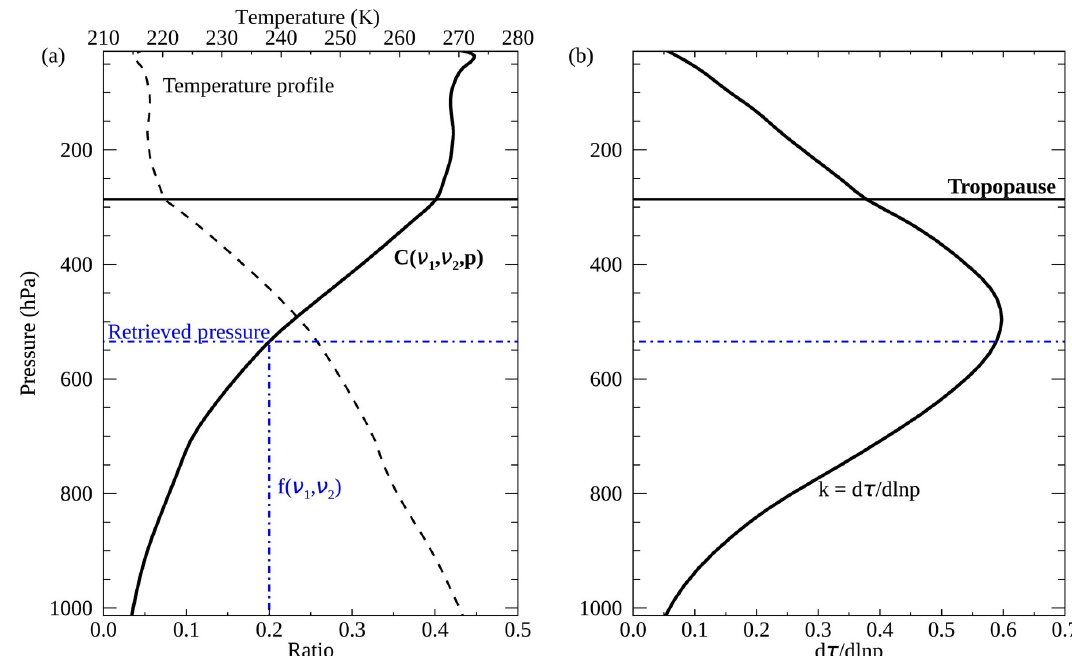
Figure 2. (a) An example of the cloud pressure function calculated using Eq. (2). This is strongly linked to the atmospheric temperature profile (dashed black line). The value obtained with Eq. (1) is compared against the cloud pressure function, and where these intersect is taken as the cloud pressure solution for that channel. In this example ν 1 and ν 2 are at 715 and 725cm − 1 respectively. (b) The corresponding weighting functions (d τ/ dln p ) which illustrate the changing sensitivity to the atmosphere. This is used to obtain a weighted average from multiple channel solutions.